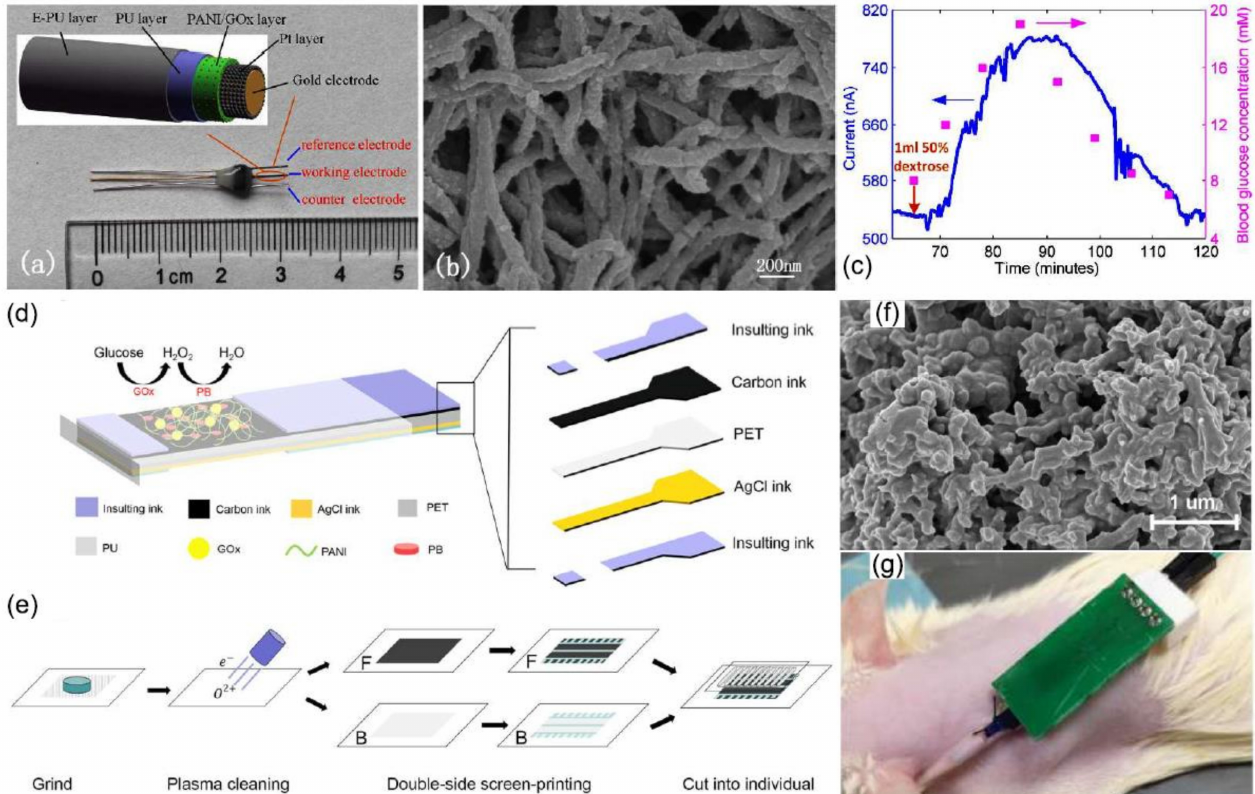
Figure 10. Implantable PAni-based biosensors for continuous glucose monitoring: ( a ) A view of the CAD design of the Pt/PAni/GOx/PU/E-PU biosensor and the real implantable device, ( b ) SEM view of the PAni NF immobilization matrix, ( c ) recorded subcutaneous glucose response (blue) for in vivo test against blood glucose measurement, ( d , e ) fabrication of PB doped/PAni/GOx/PU biosensor, ( f ) SEM view of GOx immobilized in PAni matrix, ( g ) implanted device in rat specimen for in vivo test. Images reproduced from references Lu Fang et al. [82] and Yu Cai et al.